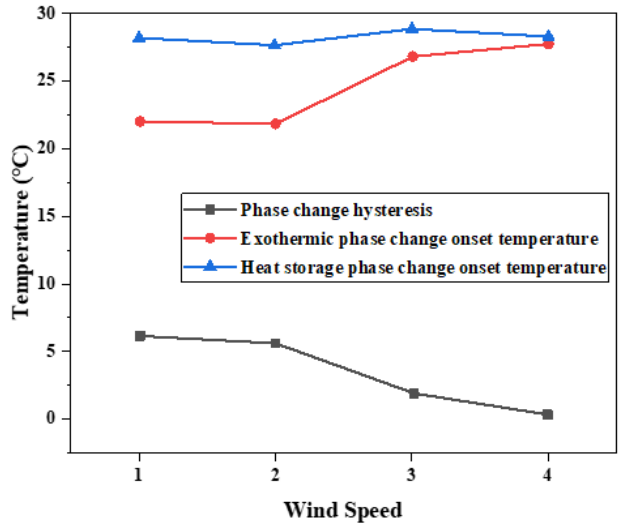
Figure 15. Influence of different cooling rates on hysteresis characteristics of phase transition.